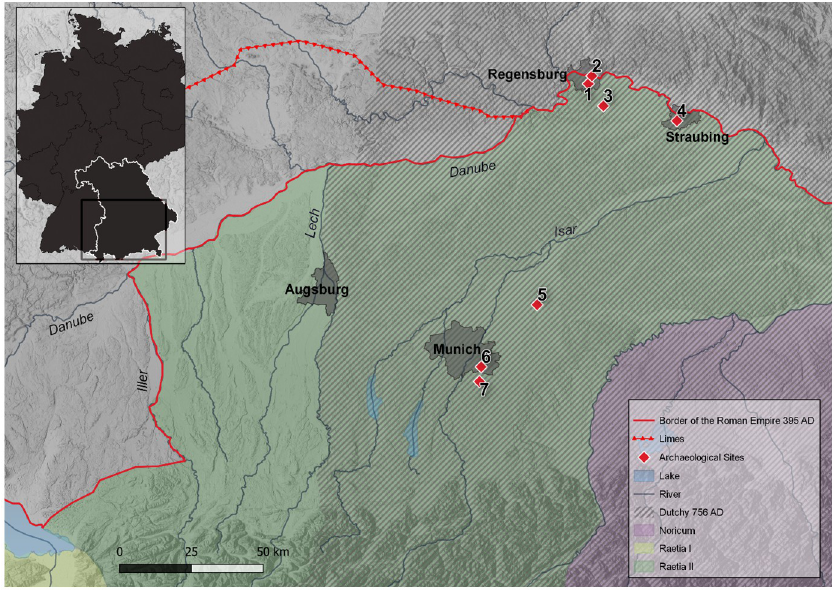
first tribal duchy of the Baiuvarii. The Limes, the Roman-Germanic border established in the 1 st century AD, was abandoned in the middle of the 3 rd century, and the river boundaries of the Rhine, Iller, and Danube became the new imperial borders. Archaeological sites in the border zone: 1 Burgweinting A and B (BWA, BWB), 2 Irlmauth (IRM), 3 Alteglofsheim (AEH), 4 Straubing-Bajuwarenstraße (STB). Archaeological sites in the hinterland: 5 Altenerding (AED), 6 Munich-Perlach (PEL), 7 Unterhaching (UTH). (Map data: WMS Digital Terrain Model https://gdz.bkg. bund.de/index.php/default/wms-digitales-gelandemodell-gitterweite-200-m-wms-dgm200.html), Data licence Germany–attribution–Version 2.0 and GeoBasis-DE / BKG (2022) [7, 8]. Boundaries of provinces and course of the Limes shown as displayed in Harbeck et al. [9], dukedom drawn as displayed in Grollmann et al. [10]), (created with QGIS 3.18.3